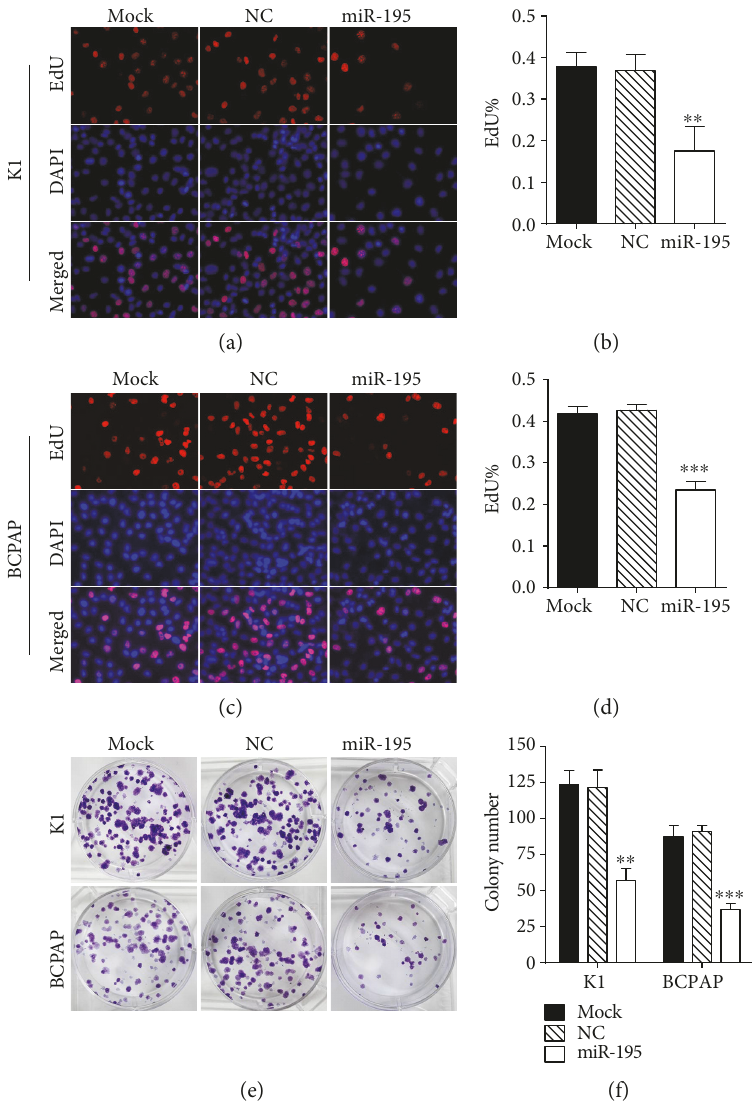
Figure 2: MiR-195 inhibits PTC cell proliferation in vitro. (a) Fluorescence images of proliferative cells (red) stained with EdU and nuclei (blue) counterstained with DAPI in K1 cells. Magni fi cation, 400x. (b) Quanti fi cation of EdU incorporation assay in K1 cells. (c) Fluorescence images of proliferative cells (red) stained with EdU and nuclei (blue) counterstained with DAPI in BCPAP cells. Magni fi cation, 400x. (d) Quanti fi cation of EdU incorporation assay in BCPAP cells. (e) Colony formation assay of K1 and BCPAP cells transfected with miR-195 . (f) Quanti fi cation of the colony number in K1 and BCPAP cells. ∗∗ P < 0 01 compared with the control group, ∗∗∗ P < 0 001 compared with the control